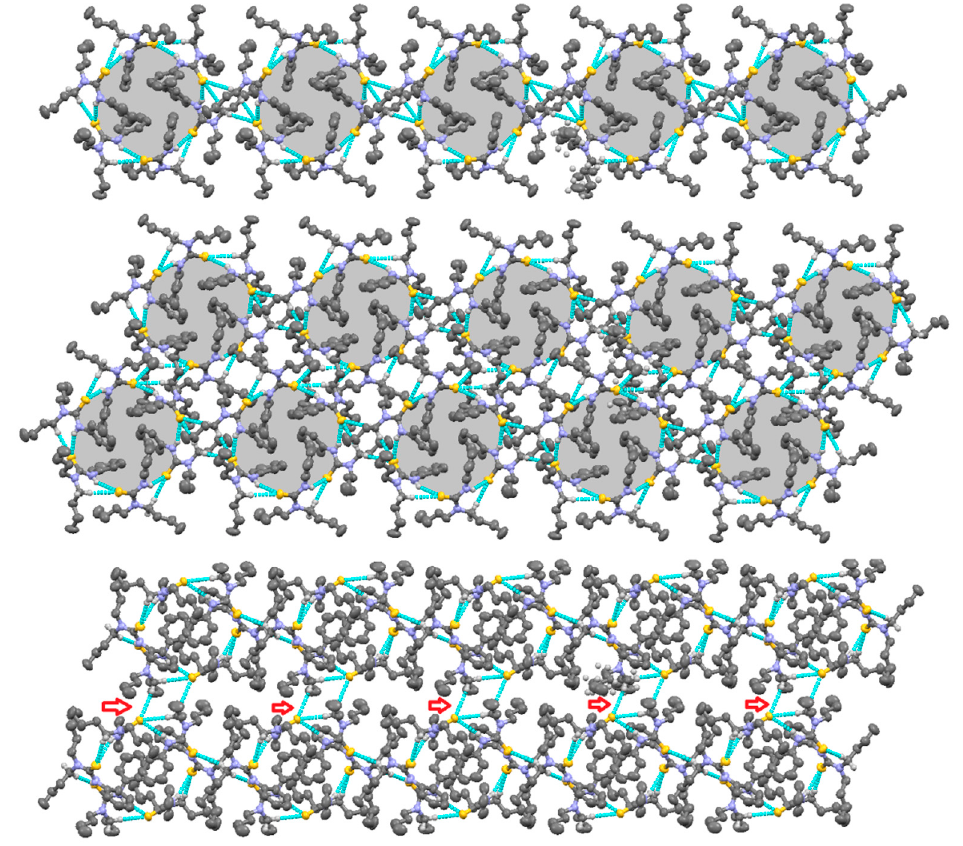
Figure 4. Different view of supramolecular structure of compound 4 , single layer of mutually con- nected hexameric units ( top ), mutually connected layers ( middle and bottom ), the molecular archi- tecture extends in a 3D manner.